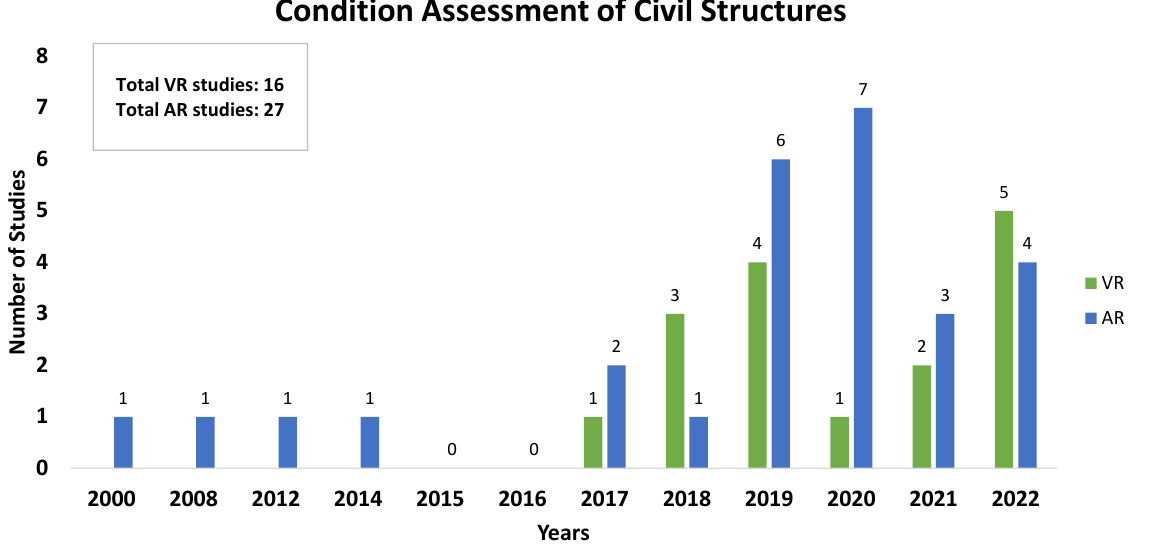
Figure 9. Number of studies included in this paper on VR and AR in condition assessment of civil structures over the years.